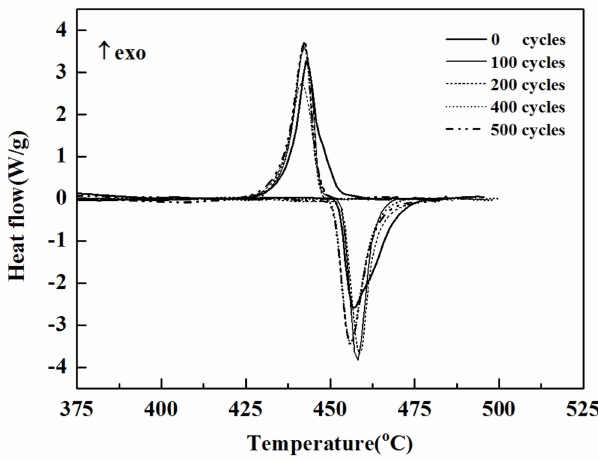
Figure 3. DSC curves of Mg–25%Cu–15%Zn alloy after different thermal cycles. Table 2. Various thermodynamic properties of Mg–25%Cu–15%Zn alloy after different thermal